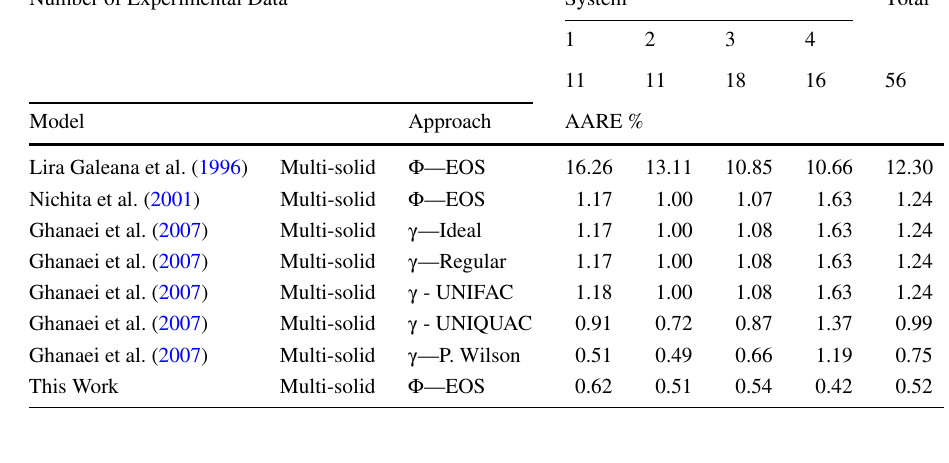
Table 8 Comparison of the models AARE